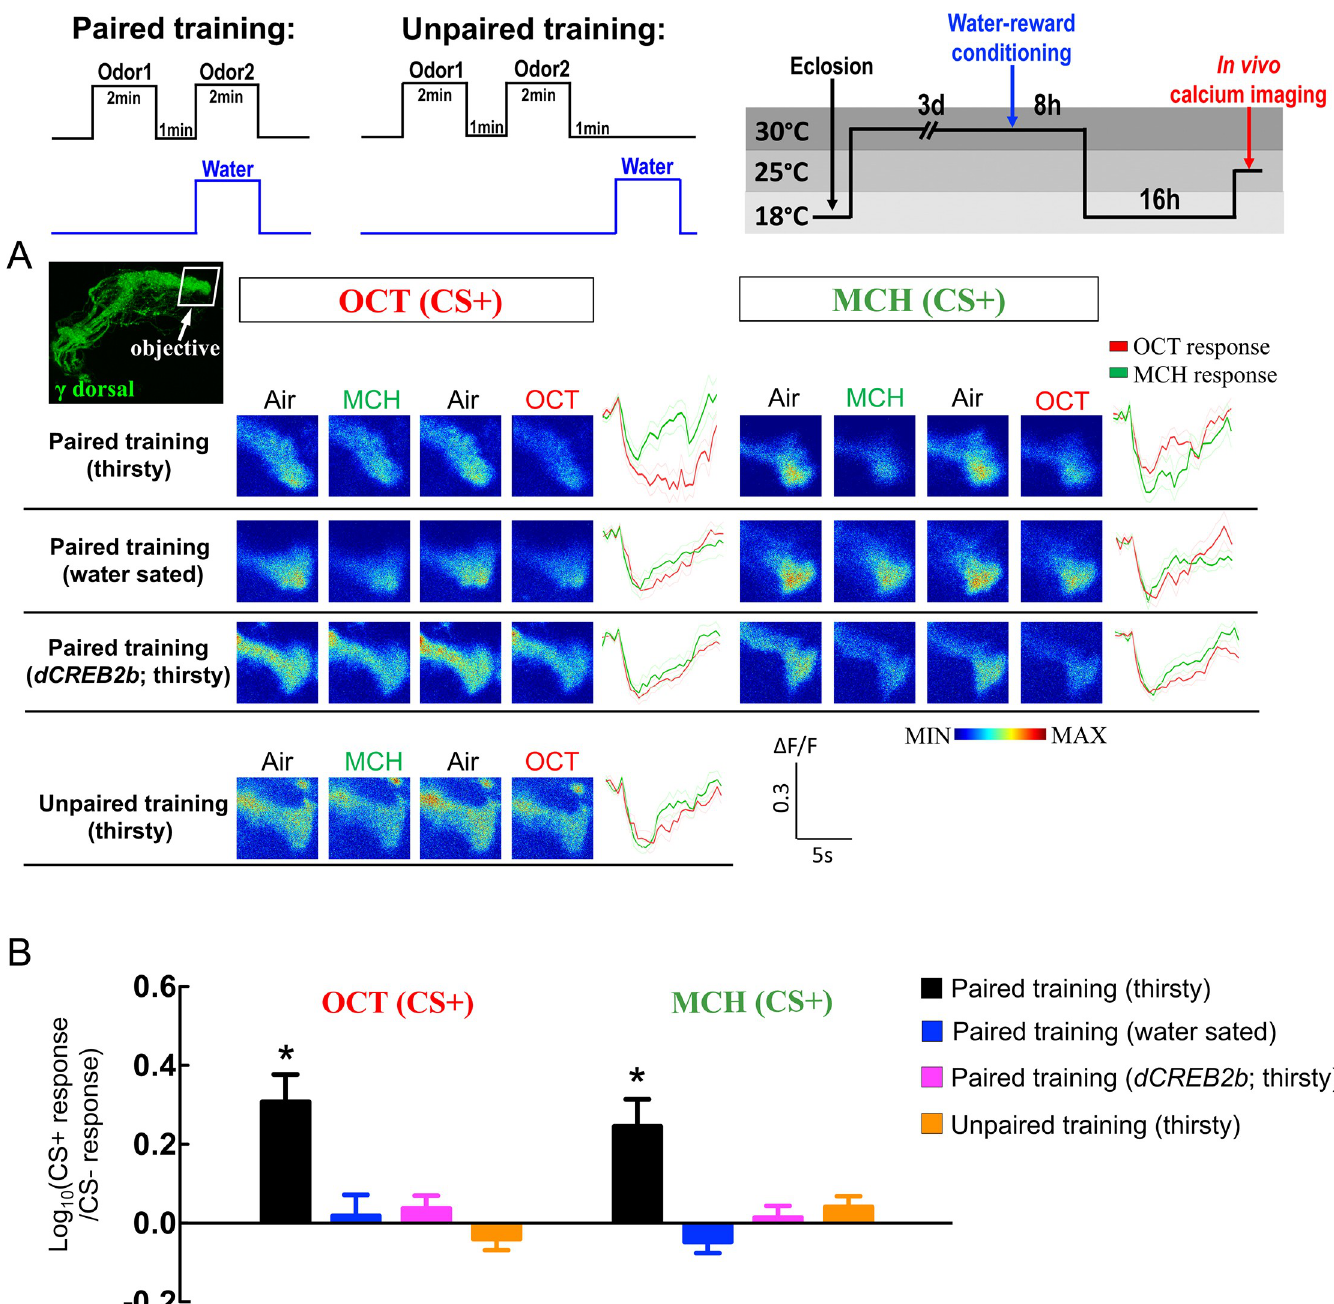
Fig 7. γ dorsal neurons show a CREB2-dependent decreased cellular calcium response to training odor at 24-hour post-conditioning. Top diagram illustrating the protocols of paired training, unpaired training, and in vivo calcium imaging. (A) The GCaMP6 response 24-hour after water-reward conditioning was assayed in γ dorsal neurons (the image-recording region is showed in the top left figure). For the paired training group: flies received CS − odor without water-reward (US), followed by exposure to the CS+ odor with water-reward. For the unpaired training group: flies received CS − odor without water-reward, followed by exposure to CS+ odor without water-reward, and the water-reward was delivered 1-minute after CS+ odor. Odor/water paired training induced an additional decrease in GCaMP6 responses in the γ -lobe region of the γ dorsal neurons to the training odor [OCT-trained flies: OCT (CS+), MCH-trained flies: MCH (CS+)] in thirsty-state. This additional decreased calcium response was abolished in water-sated state (flies allowed to drink water for 30 minutes before in vivo calcium imaging recording) or in thirsty flies with dCREB2b expression in γ dorsal neurons. (B) Quantification of the GCaMP6 responses to the training odor (CS+) relative to the non-training odor (CS − ) in the γ - lobe region of γ dorsal neurons in OCT-trained (left panel) or MCH-trained (right panel) flies at 24-hour post-conditioning. The Log ratios of the CS+ response to the CS − response were calculated using the peak response amplitudes. Each value represents mean ± SEM (N = 9~11). � , p < 0.05; statistically significantly different from zero; one sample t-test. Genotype: (1) Flies carrying UAS-GCaMP6m/tub-GAL80 ts ; R93G04-GAL4/+ transgenes were used for Paired training (thirsty), Paired training